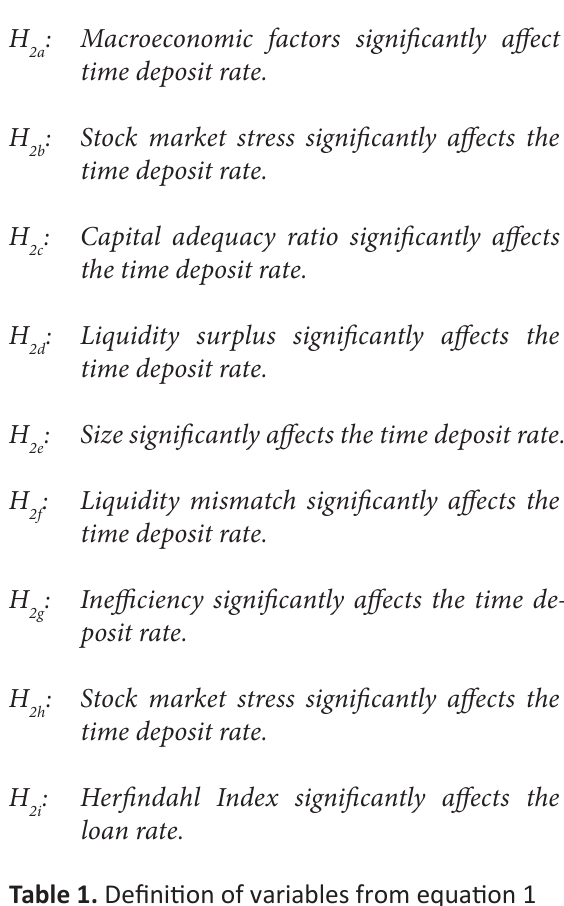
Table 1. Definition of variables from equation 1